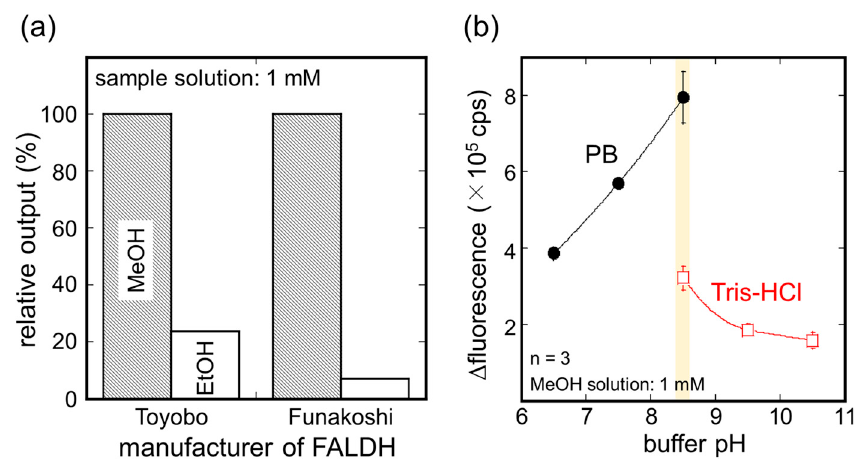
Figure 3. ( a ) Comparison of sensor output to MeOH and ethanol solutions using two different FALDH. ( b ) Influences of buffer solution pH on the activity of the AOD-FALDH membrane. Both